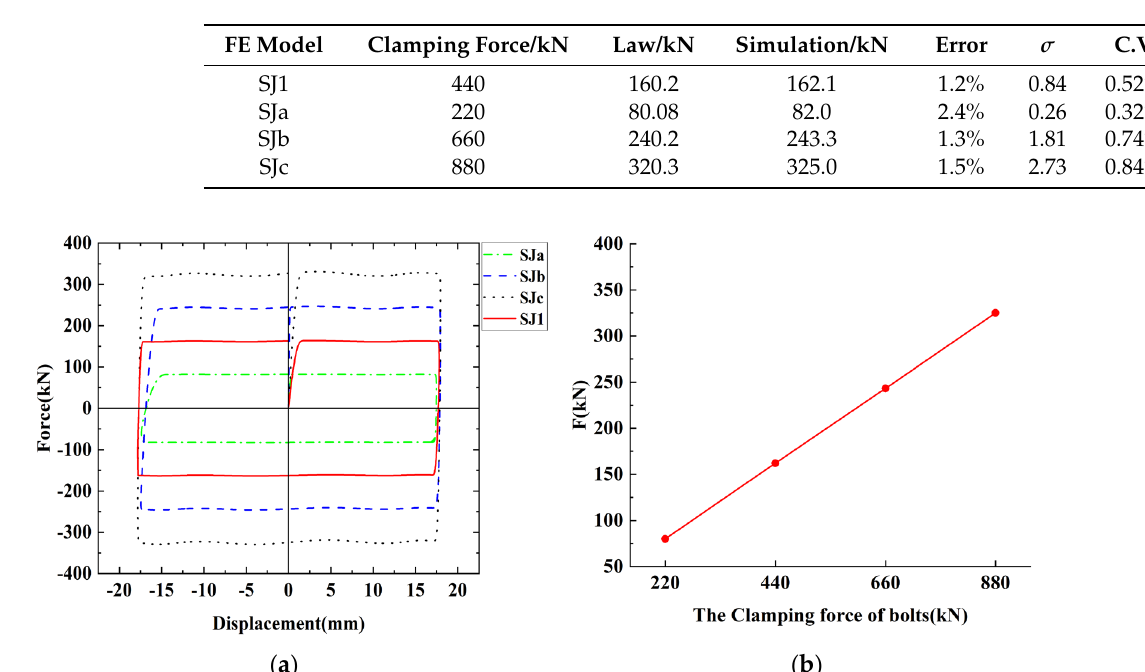
Figure 15. The comparison of hysteresis curves and average sliding friction force of the finite element simulation with different clamping force of bolts: ( a ) The comparison of hysteresis curves; ( b ) The comparison of the average sliding friction force.